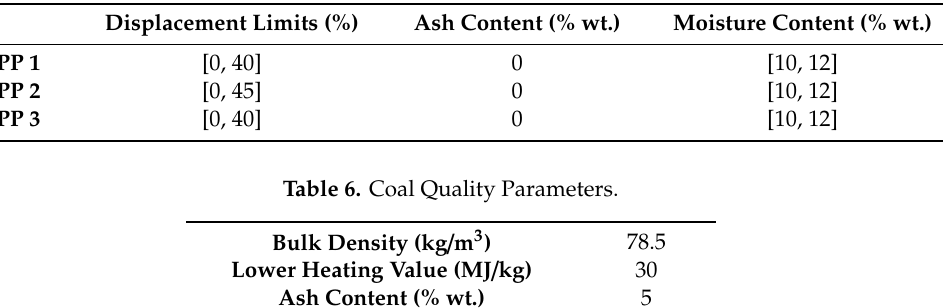
Table 5. Power Plant Facility Characteristics.